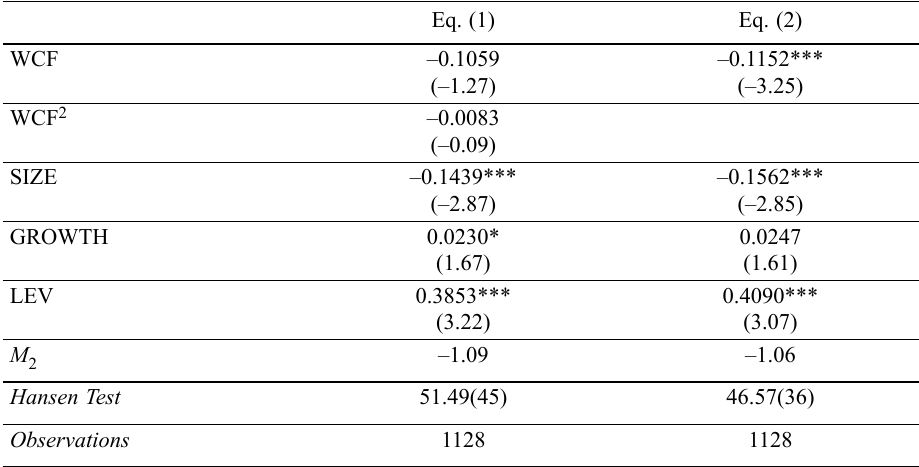
Table 5. Financing of working capital requirement and SME performance